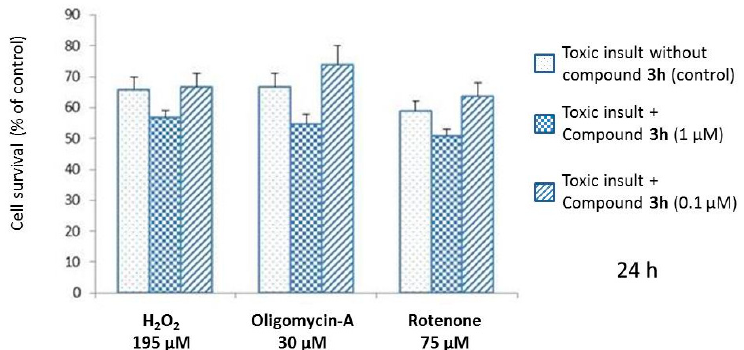
Figure 2. Neuroprotection effect of 3h on the viability of human neuroblastoma SH-SY5Y cells. Viability was measured after 24 h co-incubation of SH-SY5Y cells with the neurotoxic insult (H 2 O 2 195 µ M, oligomycin-A 30 µ M or rotenone 75 µ M) and Compound 3h at different concentrations (1 µ M and 0.1 µ M) or in the absence of 3h (control experiments). Results are expressed as the percentage of viable cells, and data represent the means ± SD ( n = 3).